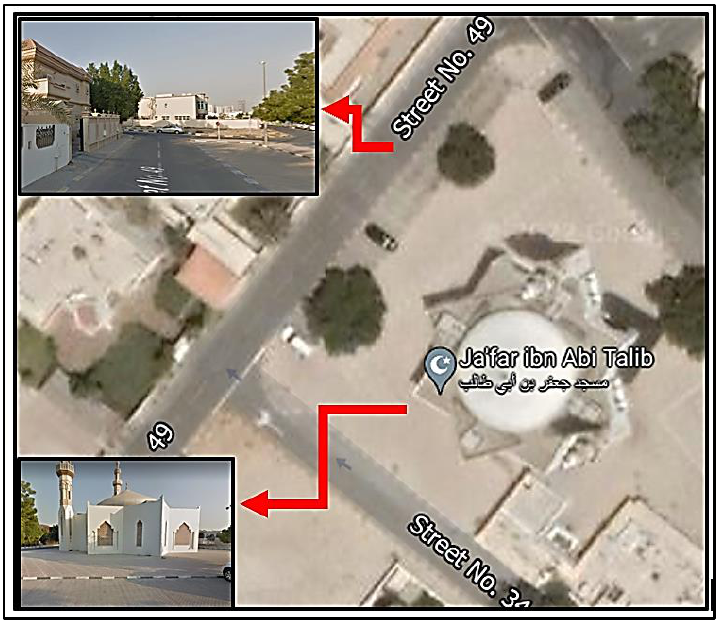
Figure 4. New district — Sharqan, Sharjah, UAE [47].